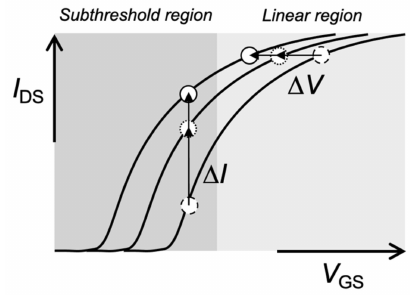
Figure 3. Schematic illustration of V GS – I DS transfer curve of